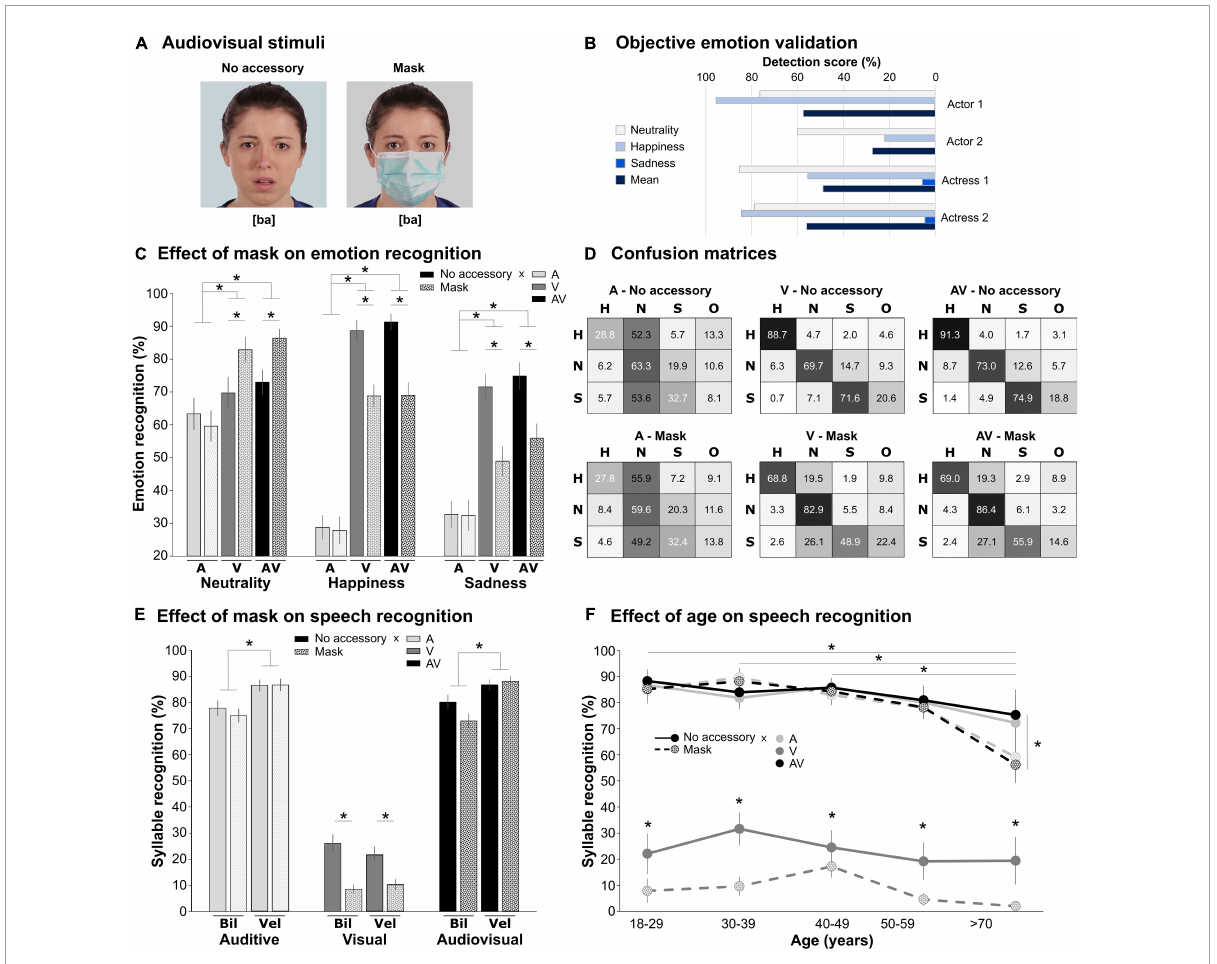
FIGURE2 Effect of mask on audiovisual emotion and speech recognition. (A) Audiovisual stimuli. The two images depict the two accessory conditions (no accessory/mask) for one actress, one emotion (sadness), and one syllable ([ba]). The images were extracted from the middle of the video when the emotion was expressed and the syllable articulated. The color of the background was adjusted, so that the two conditions had the same overall luminosity and colorimetry. (B) Objective emotion validation. Detection scores correspond to FaceReader emotion probability converted in % for the four actors and the three emotions in the no accessory condition (pooled across syllables). (C) Effect of mask on emotion recognition. Histograms represent the mean recognition score (in %, ± standard error) for neutrality (left), happiness (middle), and sadness (right), in the three modalities (A: auditive, light gray; V: visual, middle gray; and AV: audiovisual, black) in the two accessory conditions (no accessory: full, mask: pattern). * p < 0.05. (D) Confusion matrices. For each accessory × modality (A/V/AV) condition, the table presents the mean score (in %) of Happiness (H), Neutral (N), Sadness (S), or Other (O) responses (columns) as a function of the actual emotion in the video (lines: H/N/S). The gray level of each cell is proportional to the score (100%: black, 0%: white). (E) Effect of mask on speech recognition. Histograms represent the mean recognition score (in %, ± standard error) for auditive (left), visual (middle), and audiovisual (right) modalities, for the bilabial (Bil) and velar (Vel) syllables in the two accessory conditions (same color code as in panel C ). * p < 0.05. (F) Effect of age on speech recognition. Syllable recognition score (in %, ± standard error) for the three modalities and the two accessory conditions (same color code as in panel C ), pooled across syllables, as a function of the age group. * p <